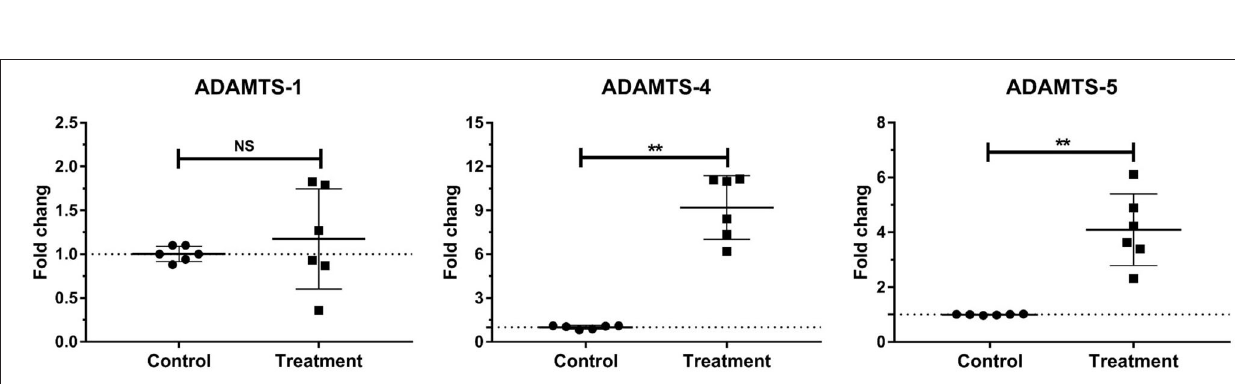
FIGURE 4 | Mean fold changes in ADAMTS-1, ADAMTS-4, and ADAMTS-5 mRNA expression following oligofructose-overload administration in dairy heifers. The values of the treatment group significantly differed from those of the control group values, indicated as ** P < 0.01; no significant differences indicated as NS.